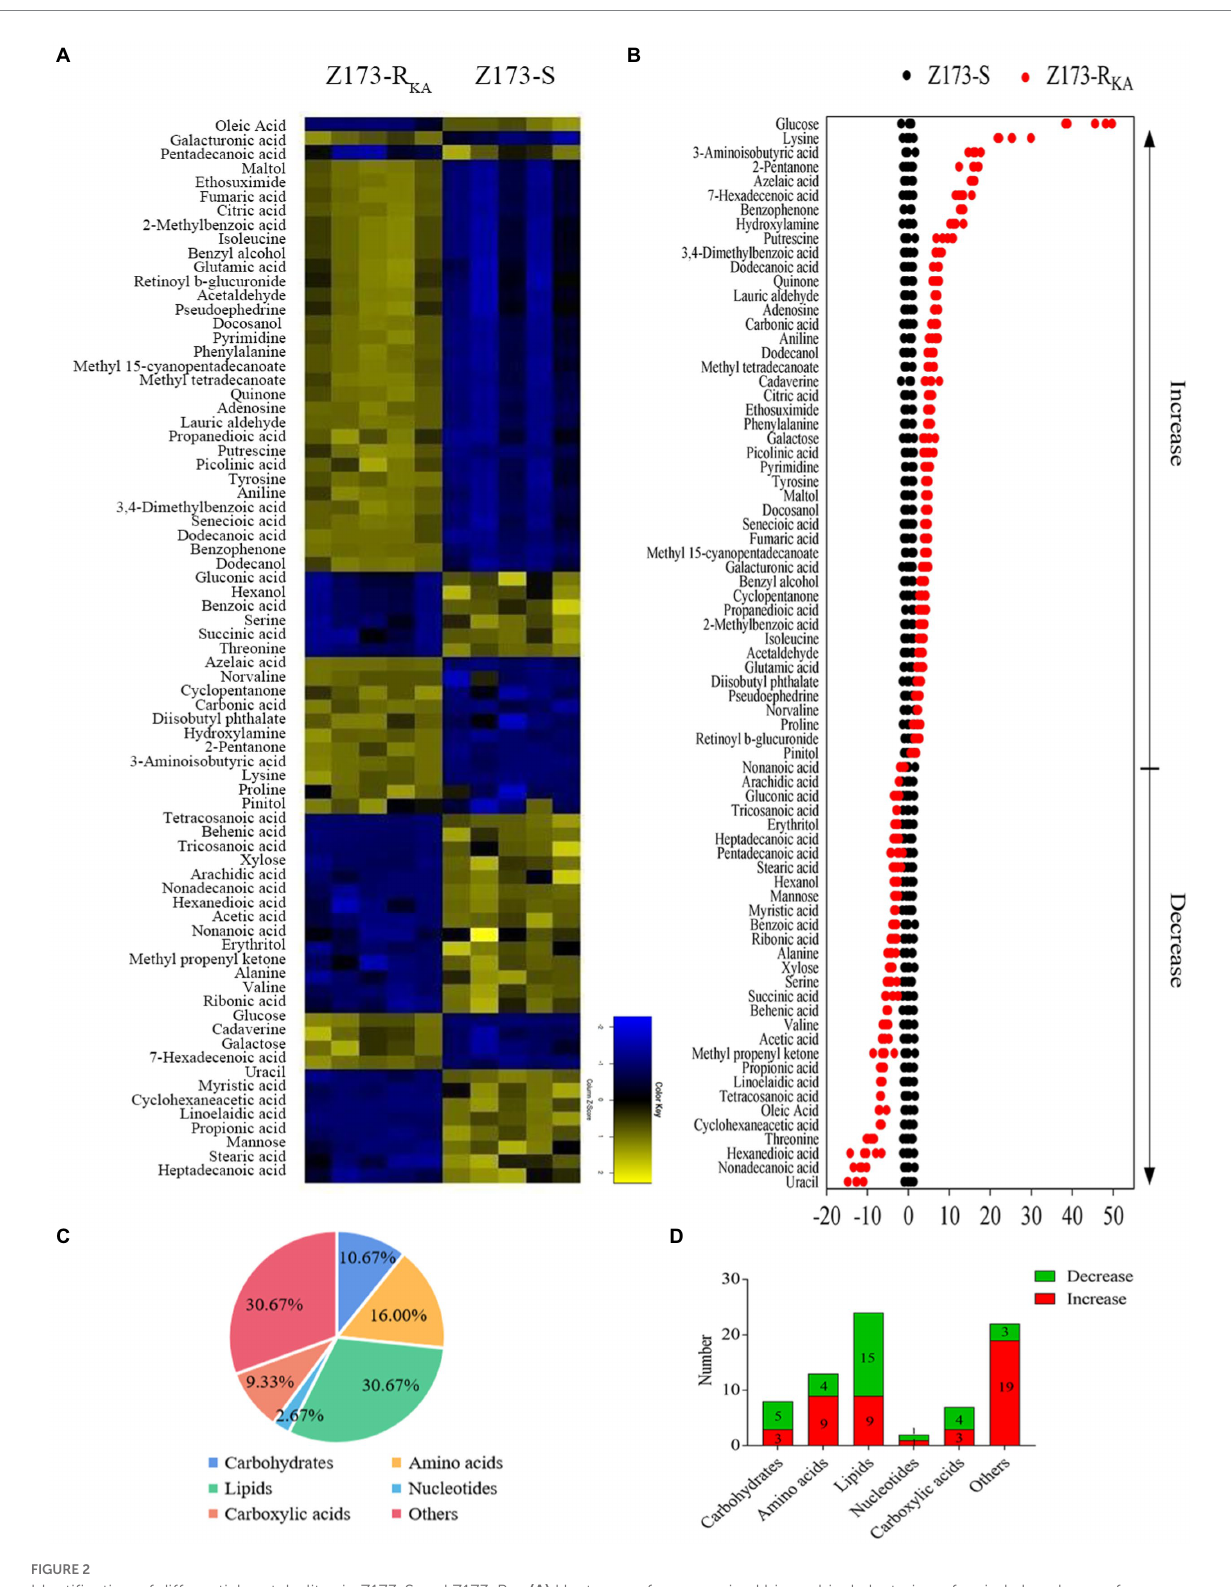
FIGURE 2 Identification of differential metabolites in Z173-S and Z173-R KA . (A) Heat map of unsupervised hierarchical clustering of varied abundance of metabolites. Yellow and blue indicate increase and decrease of metabolites relative to the median metabolite level, respectively (see color scale). (B) Z-score plots. Each point represents one metabolite in one technique repeat. Black and red represent Z173-S and Z173-R KA, respectively . (C) Category of varied abundance of metabolites. (D) Number of metabolites increased and decreased in six